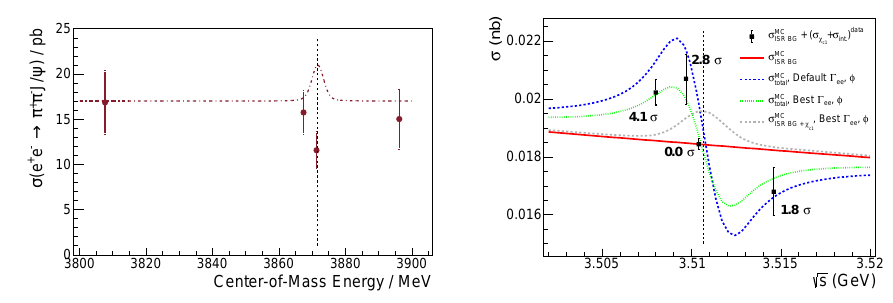
Figure 3. Cross sections of e + e − → π + π − J /ψ in the vicinity of the X (3872) (left panel, [19]) and those of e + e − → γχ c 1 in the vicinity of the χ c 1 (right panel,